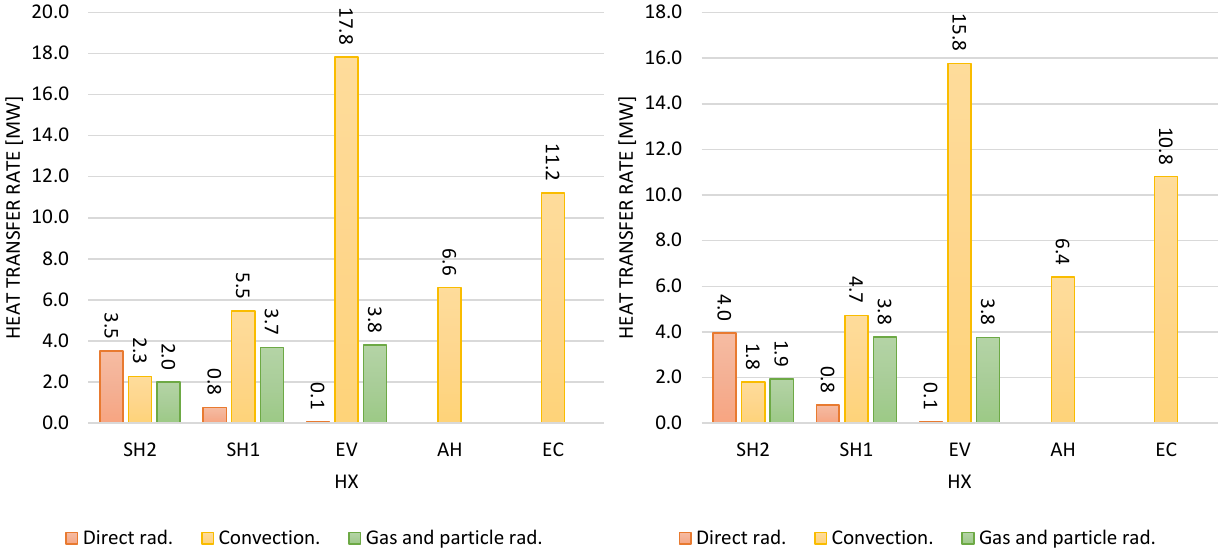
Convection. Gas and particle rad. Convection. Figure 13. Breakdown of heat transfer rates per mechanism for M1 ( left ) and M2 ( right ) for industrial-scale biomass-fired boiler model.